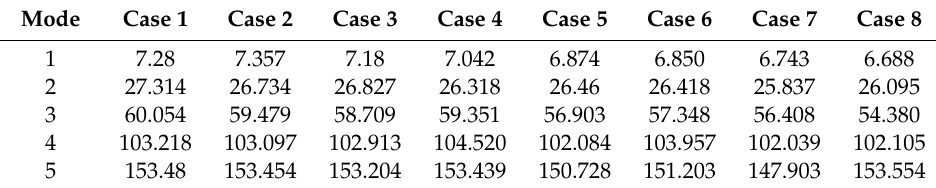
Table 7. The measured natural frequencies of eight cases.